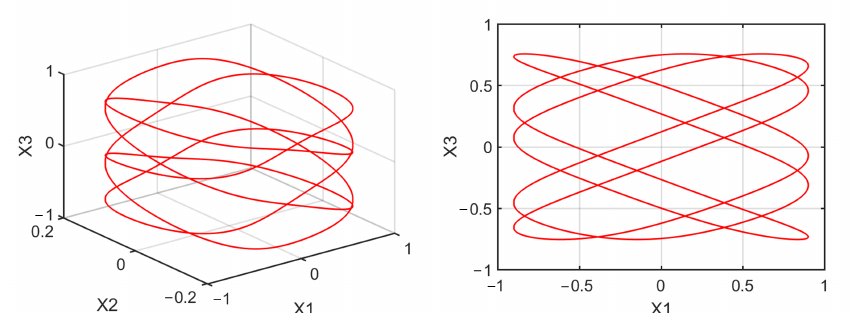
Figure A3. Periodic-5 motion of σ 2 = 0.3124.